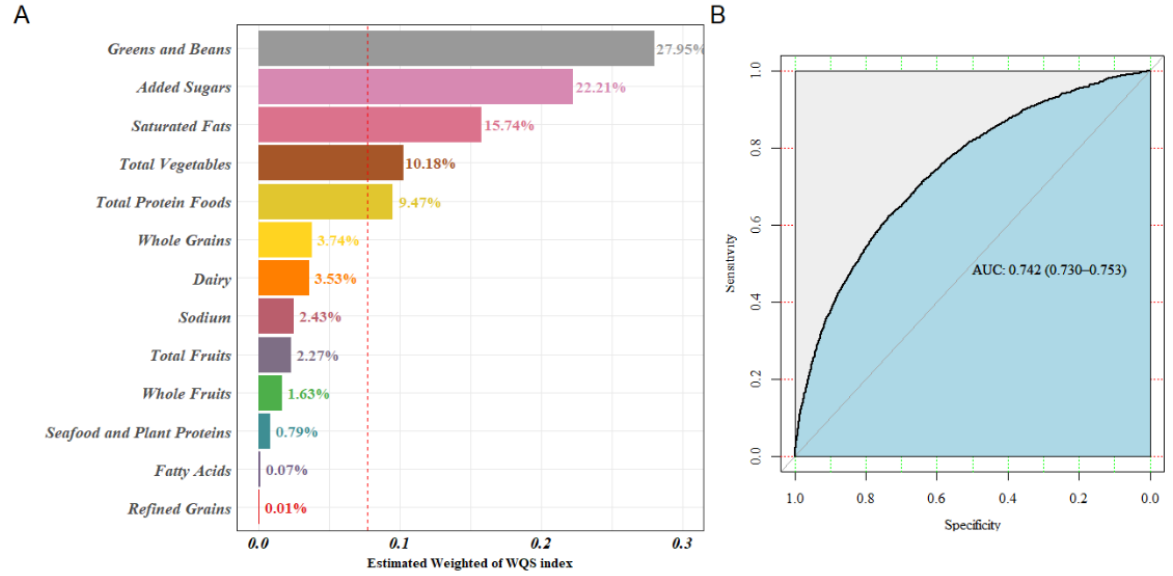
Figure 3. WQS regression index weights for sleep disorders. ( A ) ROC curve of the WQS model ( B ). The area under the curve was 0.742 (95% CI: 0.730–0.753), which indicated that